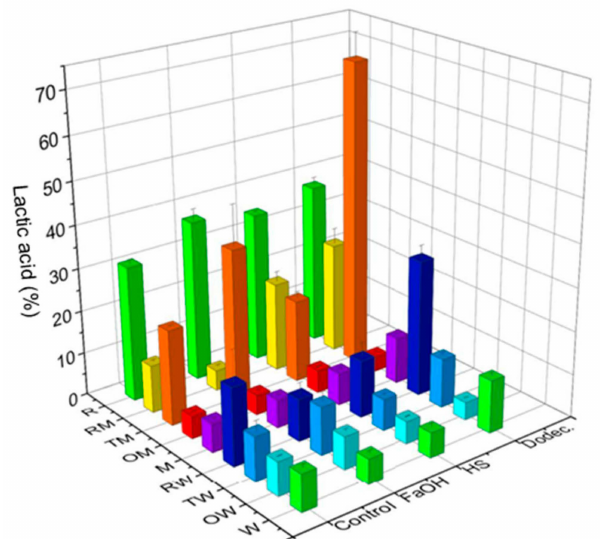
Figure 3. LA production (% of the theoretical maximum) in pure cultures or co-cultures of the microorganisms selected with pure commercial starch as carbon source (24 h, 200 rpm, 28 ◦ C). Microorganisms: R. oryzae (R), T. amestolkiae (T), O. piceae (O), L. plantarum M9MG6-B2 (M), L. plantarum WCFS1 (W) and their combinations. Farnesol (FaOH), 3-oxo-C12-HSL (HS) or dodecanol (Dodec.) were added to the cultures and the LA produced was compared with that from untreated cultures